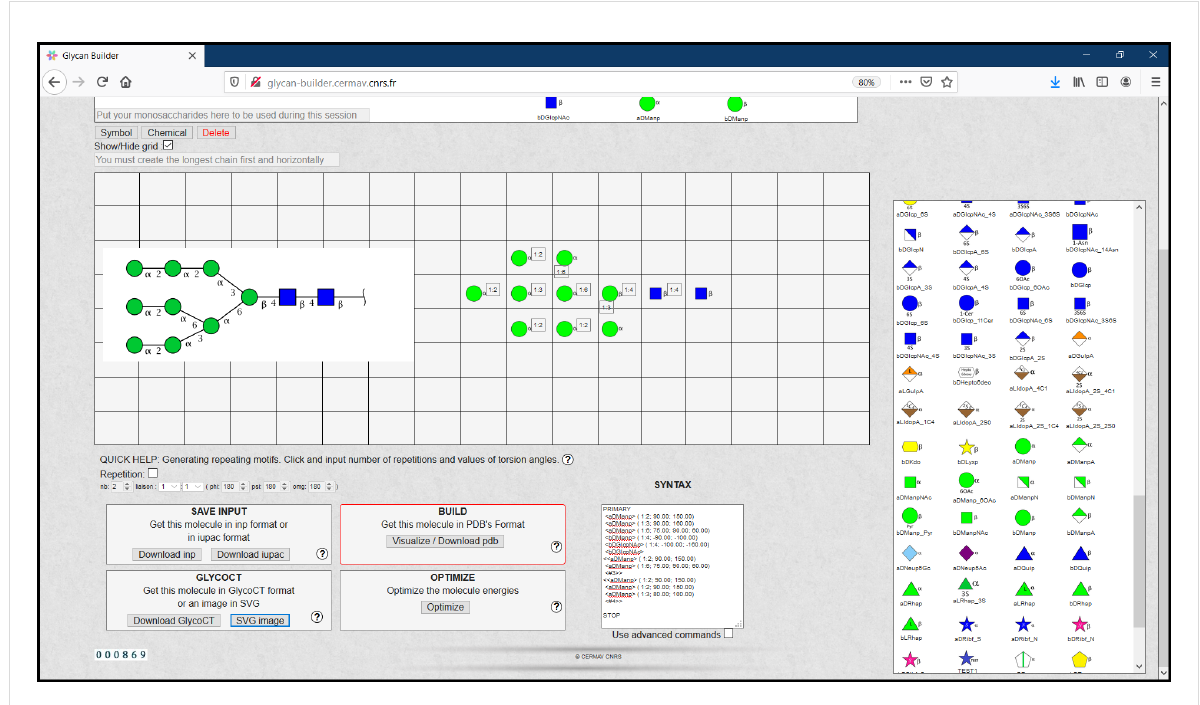
Figure 10: PolysGlycanBuilder [77] interface illustrating glycan drawing using SNFG symbols. The glycan can be further converted into a 3D